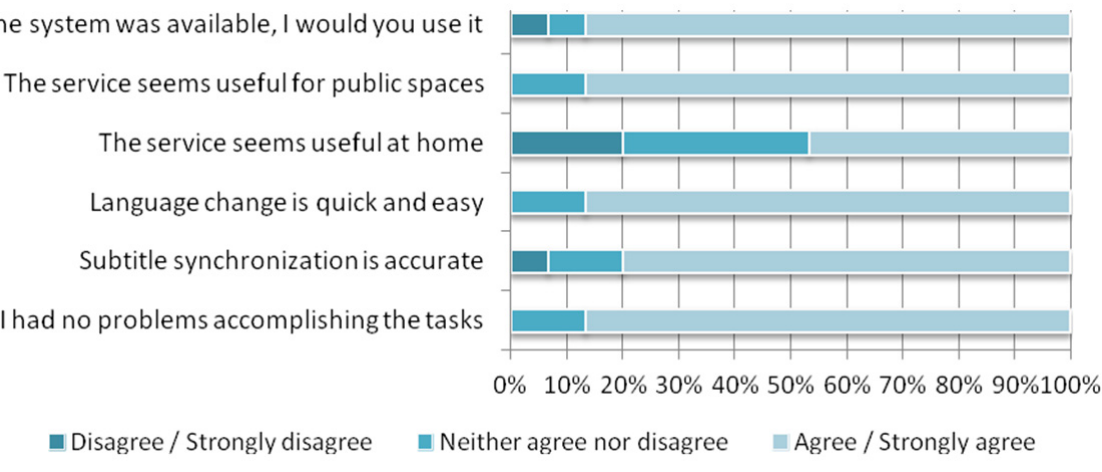
Figure 11. The summarized results of the user experience